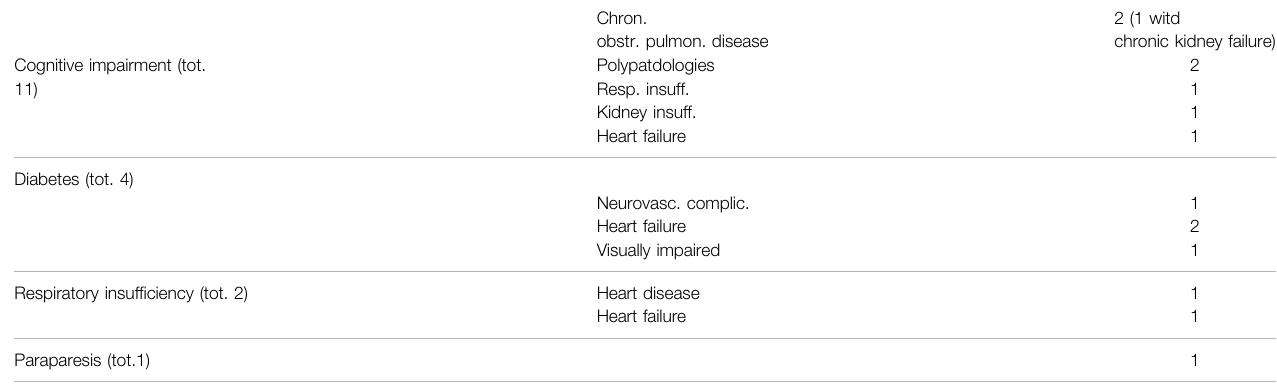
TABLE 1 | Synoptic picture of the declared morbidity.